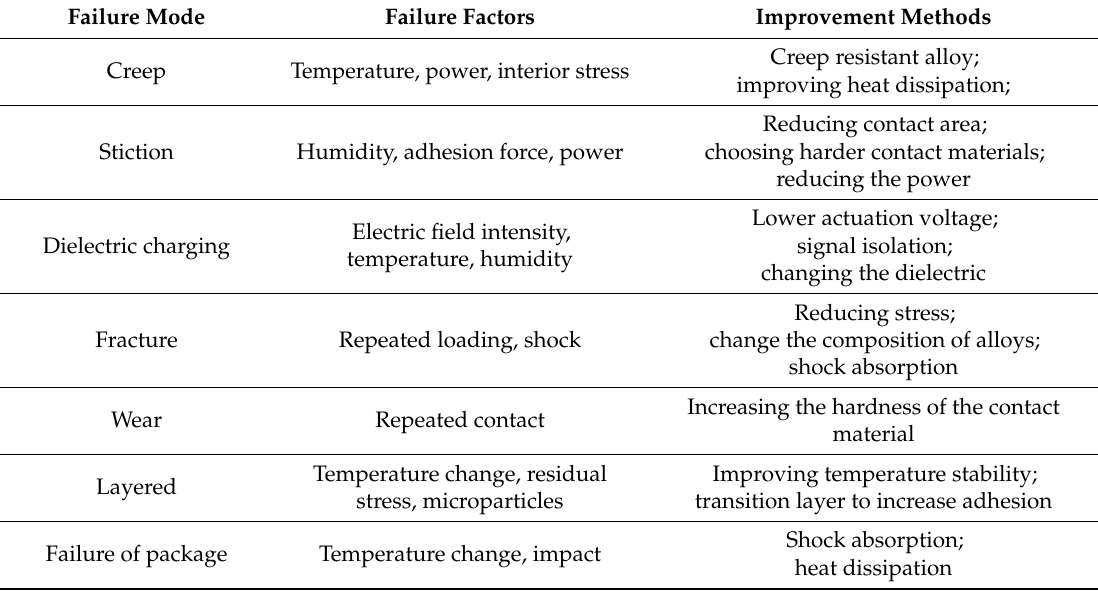
Table 1. Failure mode analysis of MEMS